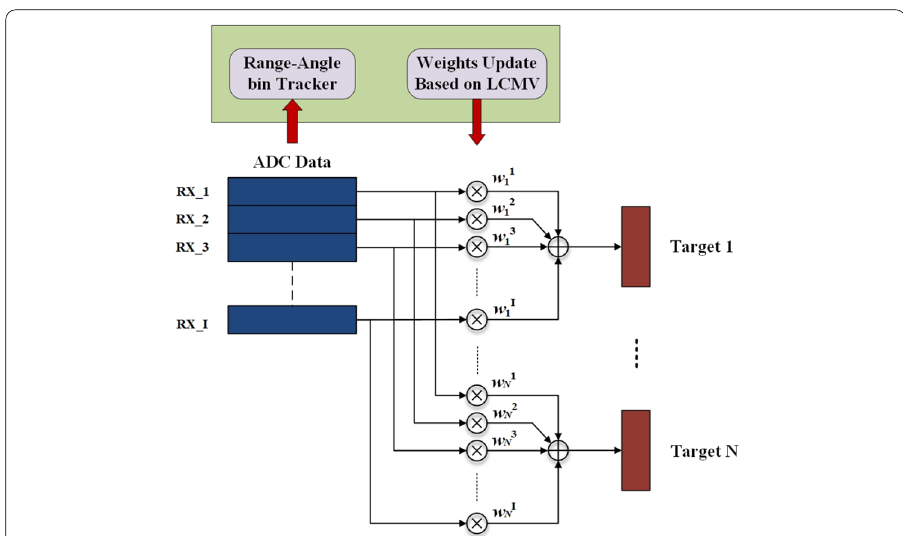
Fig. 6 LCMV-ADBF processing of FMCW radar